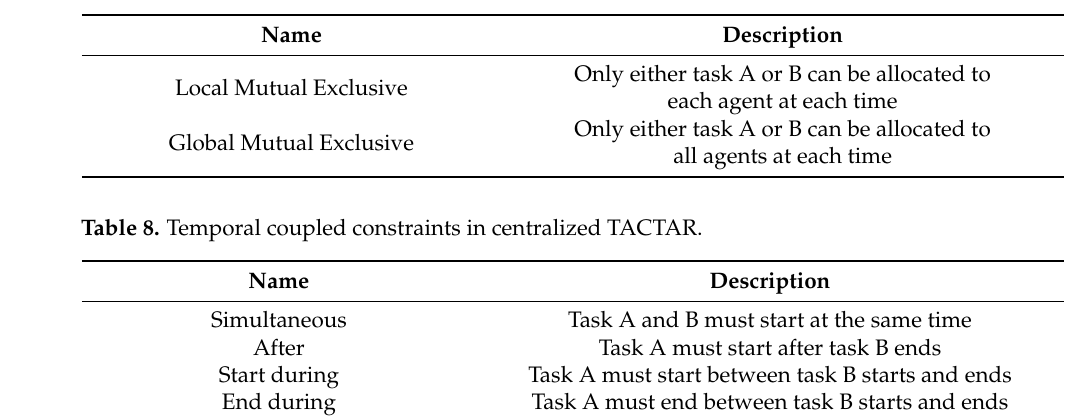
Table 7. Spatial coupled constraints in centralized TACTAR.